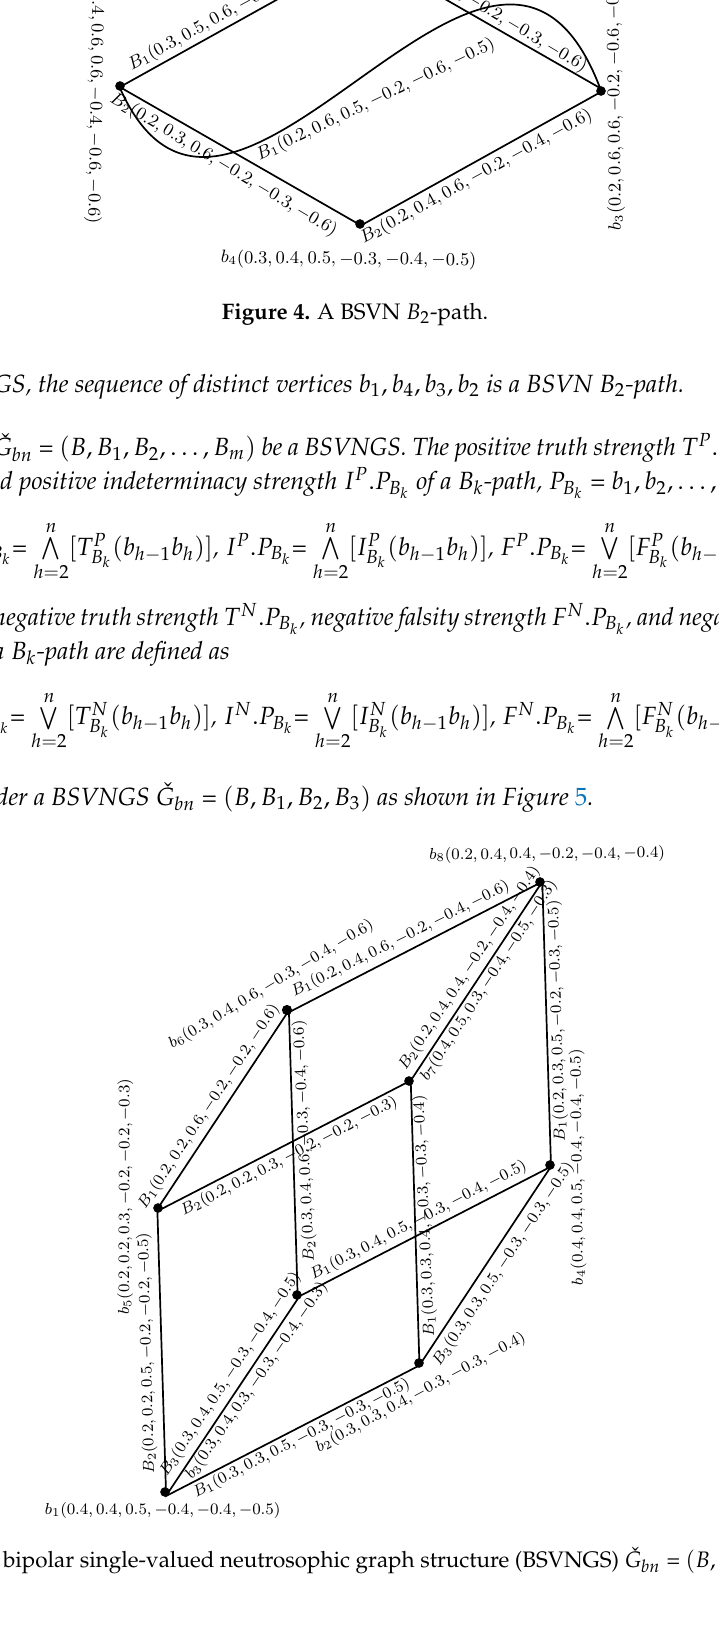
Figure 2.5: A BSVNGS ˇ G bn = ( B, B 1 , B 2 , B 3 ) Figure 5. A bipolar single-valued neutrosophic graph structure (BSVNGS)